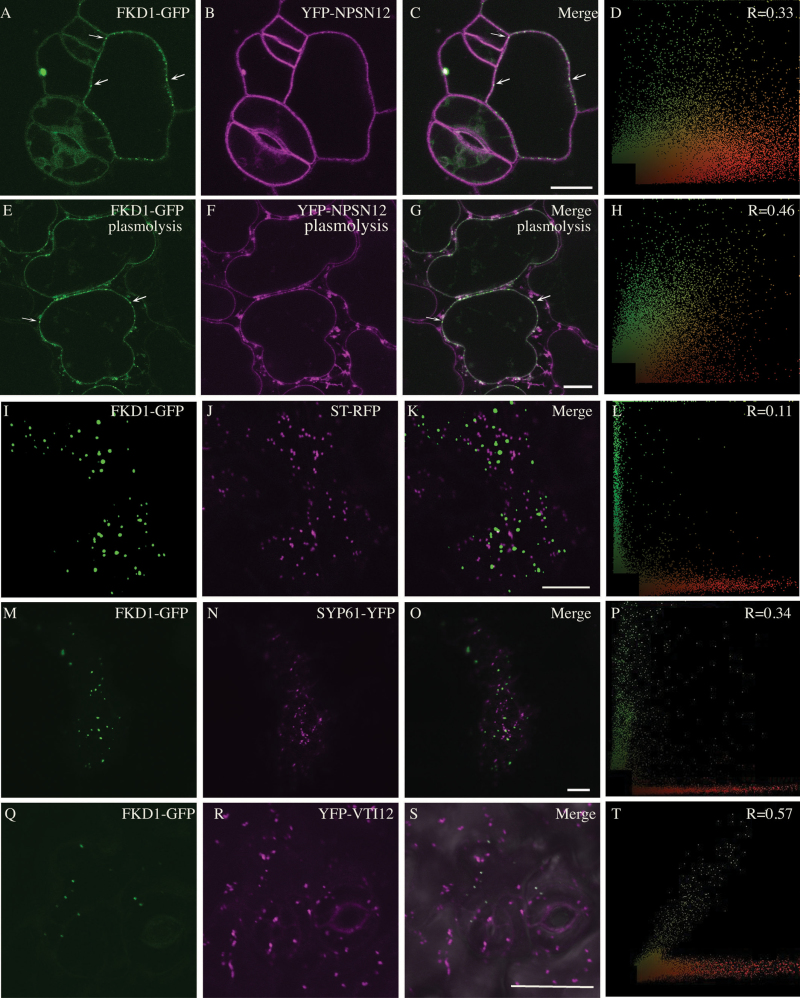
35S:FKD1–GFP localizes to the plasma membrane and trans-Golgi, but not to the Golgi. Localization in stably transformed 2.5 DAG Arabidopsis cotyledon pavement cells of 35S:FKD1–GFP with the plasma membrane marker UBQ10:YFP–NPSN12 (A–H) before (A–D) and after (E–H) plasmolysis treatment (800 mM mannitol, 3 h). (A and E) 35S:FKD1–GFP alone; (B and F), UBQ10:YFP–NPSN12; (C and G) merged images; (D and L) scatter plots of the merged image with Pearson’s coefficient of correlation (R) values. Arrows in (A), (C), (E), and (G) indicate bright foci of FKD1–GFP localization. Localization in transiently expressing Nicotiana tabacum of 35S:FKD1–GFP with the Golgi marker 35S:ST–RFP (I–L) or TGN marker 35S:SYP61–YFP (M–P); (I and M) 35S:FKD1–GFP alone; (J) 35S:ST–RFP; (N) 35S:SYP61–YFP. (K and O) Merged images; (L and P) scatter plots of the merged image with Pearson’s coefficient of correlation (R) values. Localization in stably transformed 2.5 DAG Arabidopsis cotyledon pavement cells of 35S:FKD1–GFP with the TGN marker UBQ10:YFP–VTI12 (Q–T); (Q) 35S:FKD1–GFP alone, (R) UBQ10:YFP–VTI12, (S) merged images, (T) scatter plot of the merged image with Pearson’s coefficient of correlation (R) value. Scale bar=10 μm.